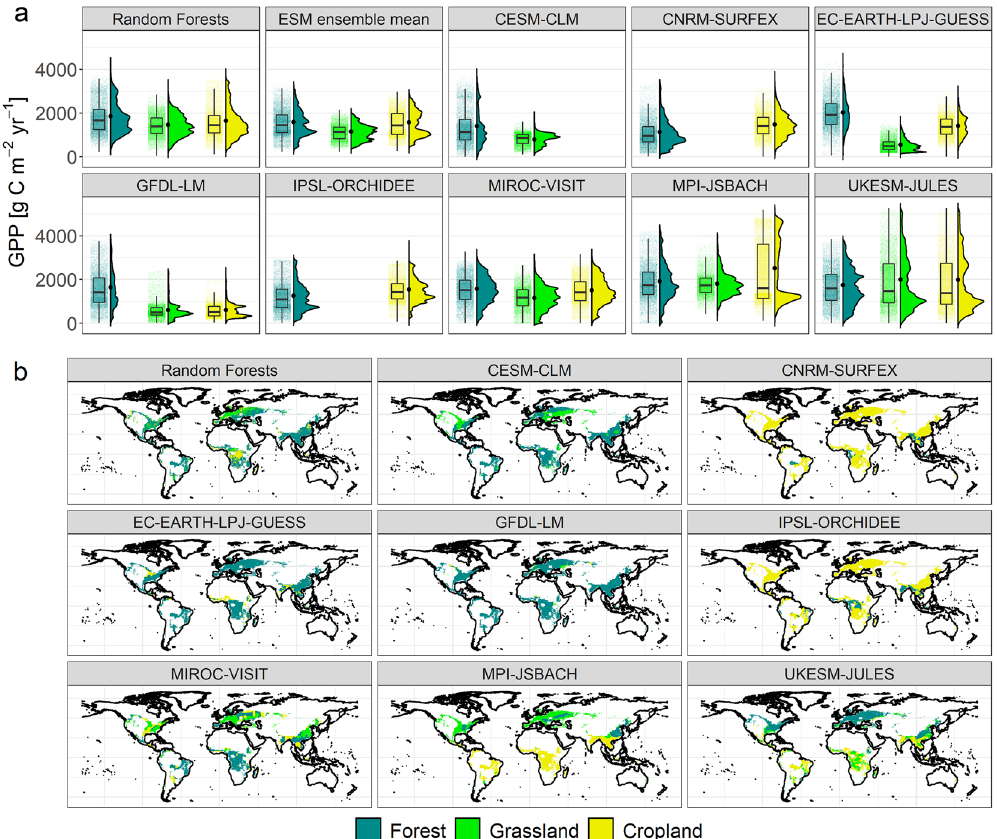
Figure 3. Comparison of our RF GPP predictions to CMIP6 ESM simulations. ( a ) Box and violin plots of GPP probability densities for different land cover types in our RF approach, eight ESMs and the ESM ensemble (2001–2014 mean values). The tiny coloured dots correspond to individual grid cells (subset of 1% randomly selected cells), the larger black dots indicate area-weighted means across all grid cells. ( b ) Maps of the most productive land cover type. ESM considerably vary in their spatial resolutions and simulated forest cover so we bilinear remapped the output to 0.05° resolution using Climate Data Operators 33 and removed grid cells without any trees in at least one ESM, i.e., we compare the same area for all models. Maps of the most productive land cover type on the original ESM spatial resolution can be found in Supplementary Fig. S10. The figure